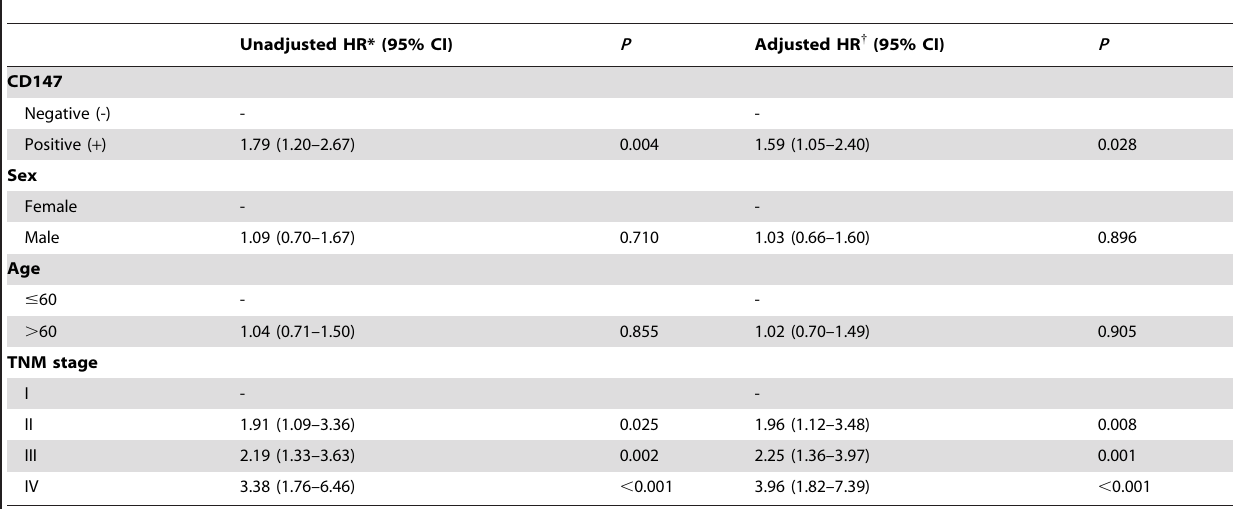
*Hazard ratios in univariate models. { Hazard ratios in multivariable